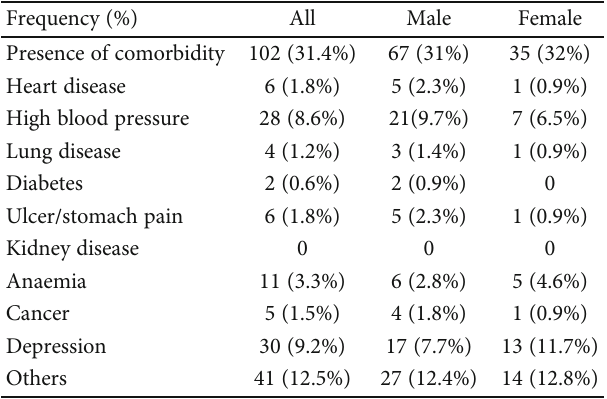
Table 4: Prevalence of the type of non-MSK comorbidity among